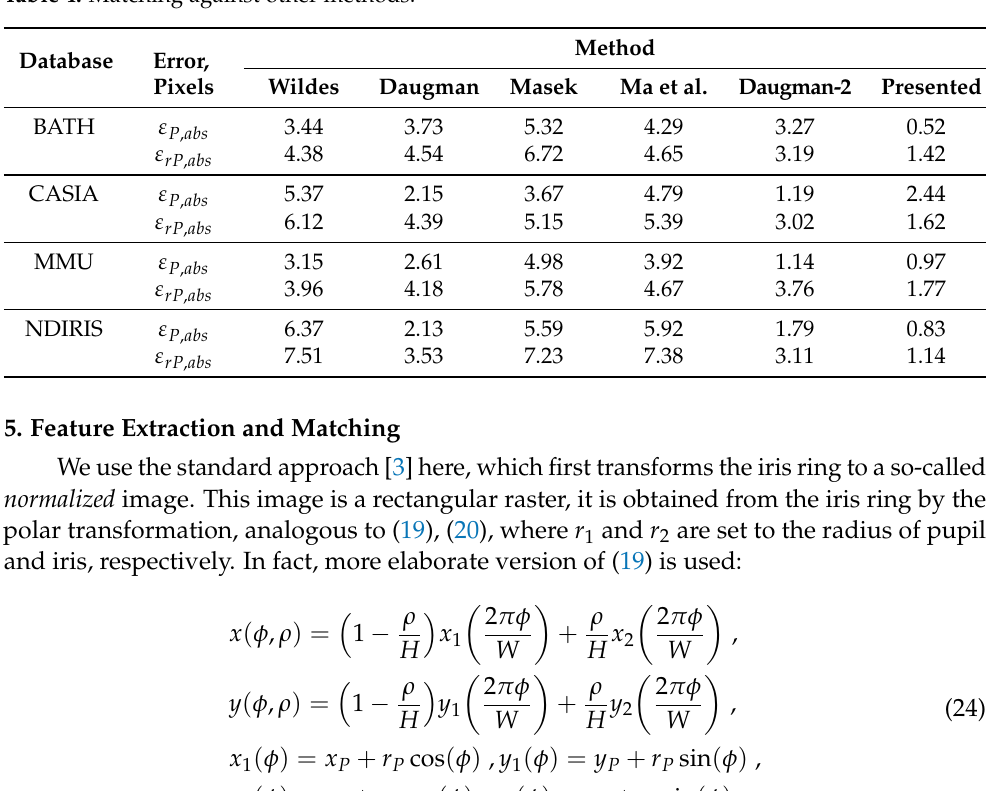
Table 4. Matching against other